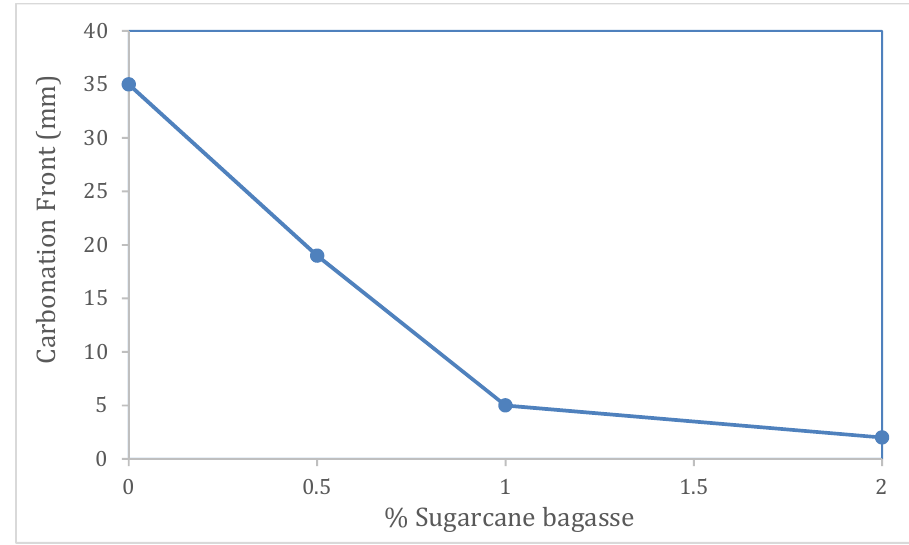
Figure 6. Progress of carbonation for the concrete samples with different amount of fibers added: control (0%), 0.5%, 1% and 2%.